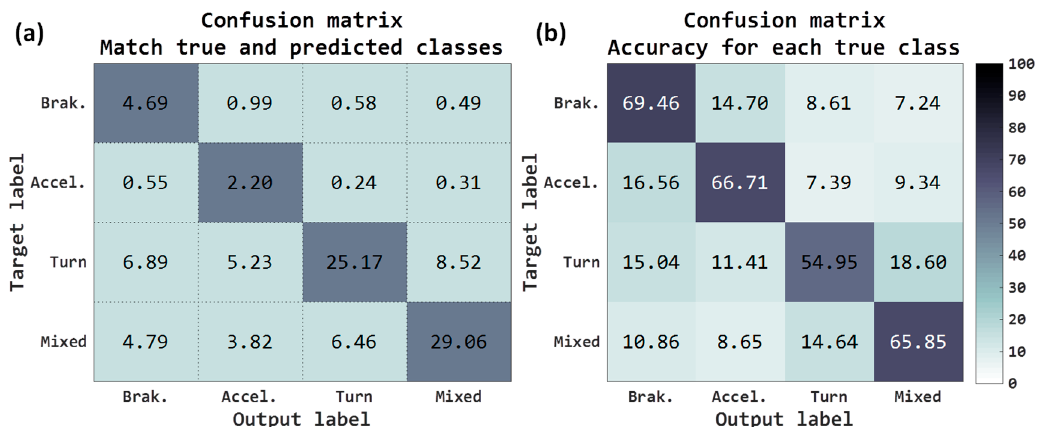
Figure 10. Confusion matrix on raw accelerometers tests removing gravity and adding speed estimation: ( a ) according to the number of tested maneuvers, ( b ) according to the type of maneuver. Table 5. VMD results using raw accelerometers removing gravity adding speed estimation.